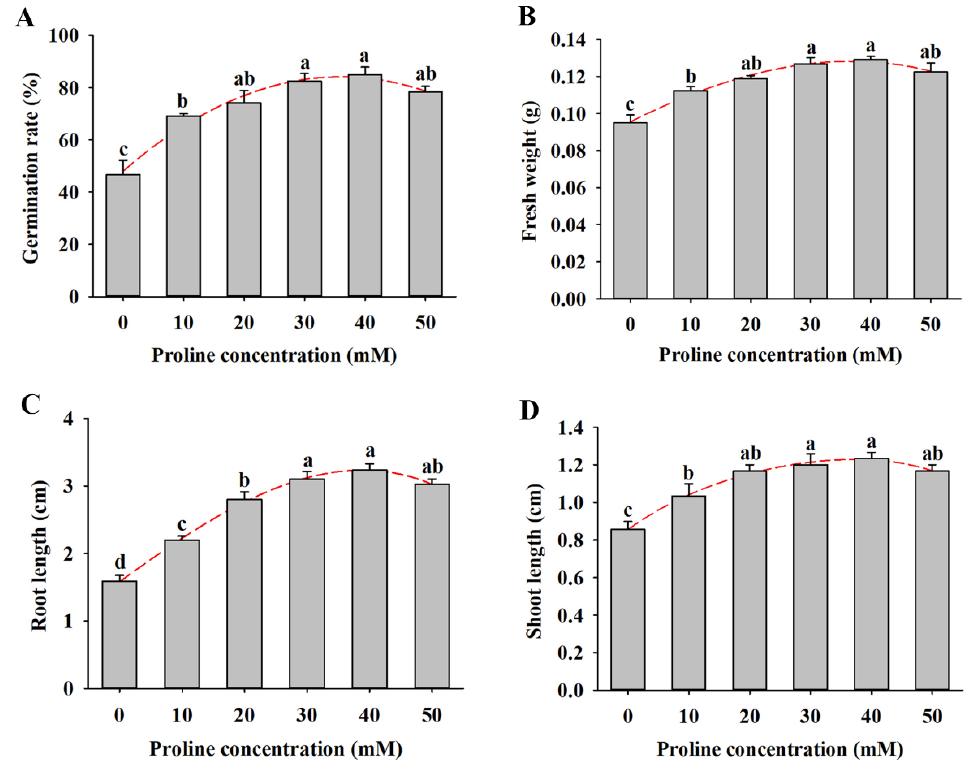
Figure 2. Effects of different concentrations of proline (0, 10, 20, 30, 40, and 50 mM) treatment on seed germination and seedling growth of alfalfa under salt stress for 14 d. (A) Germination rate. (B) Fresh weight. (C) Root length. (D) Shoot length. Data are means ± SE ( n = 40), and different letters indicate significant differences between groups ( p < 0.05).